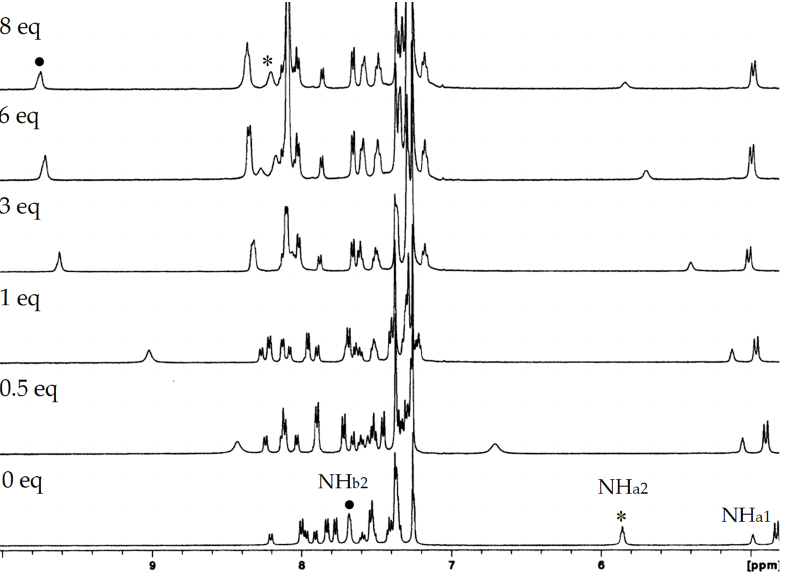
Figure 1. 1 H NMR partial spectra (500 MHz, CDCl 3 , 25 °C) of Naphturea 4a with several equiv of TBA BzO.